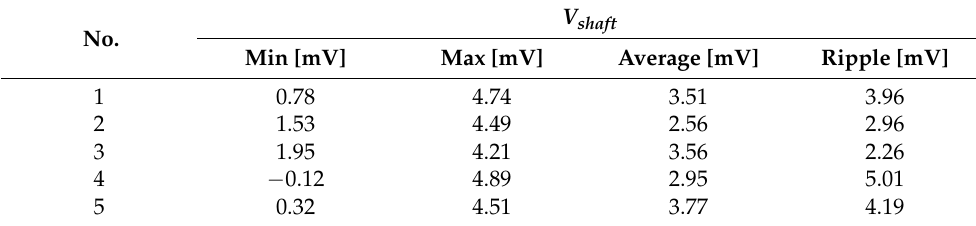
Table 2. Second test result using a potential sensing voltage of 0.001 mV and an input stage smooth- ing circuit.